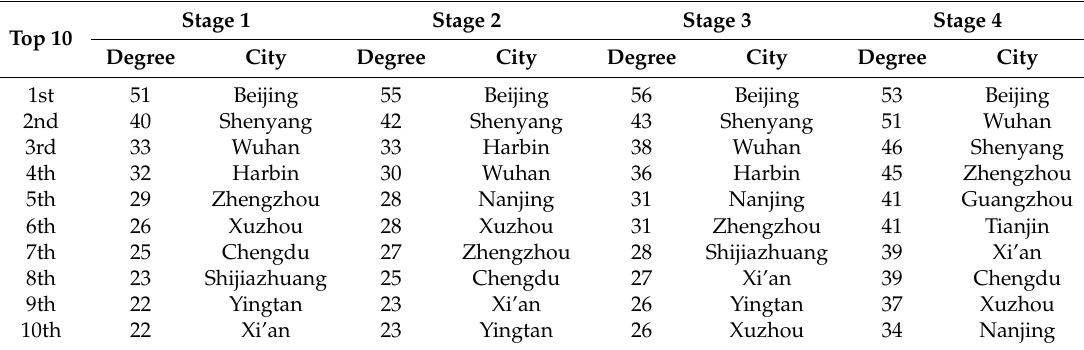
Table 7. Degree for the top 10 cities in four stages.